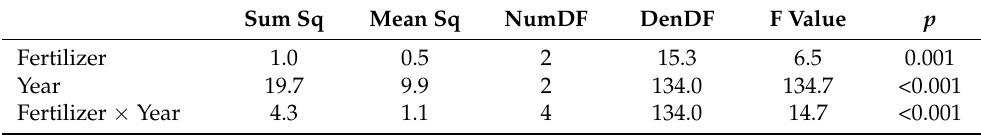
Table 6. Effects of fertilizer and year on the cumulative cover of grasses according to the